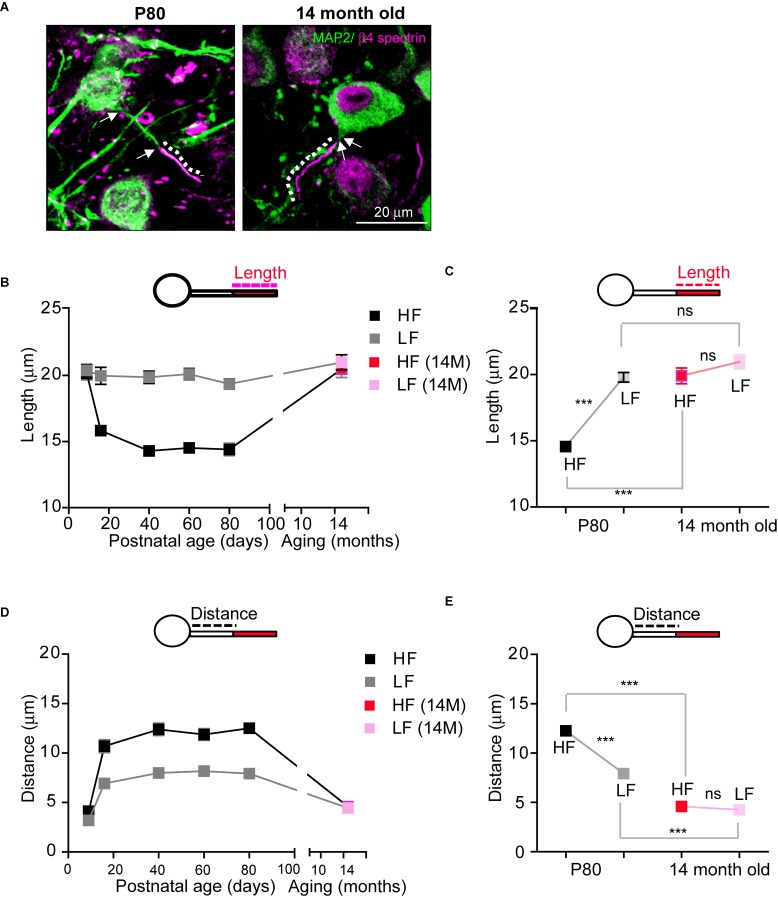
The structural stability of the AIS of MNTB neurons is disrupted in aged mice. (A) HF neurons were immunostained with MAP2 and β4 spectrin in adulthood (P80) and in an aged mouse (14-month-old; 14M). The dotted line and white arrow indicate AIS length and distance, respectively. (B) The plot of AIS length in HF (black) and LF (gray) neurons through lifetime from P9 to 14M and AIS length of HF (red) and LF (pink) in aged mice. (C) Tonotopy of AIS length in MNTB neurons from adult (at P80, black) and aged (14M, magenta) mice. ∗∗∗p < 0.0001, Mann–Whitney U test. (D) The plot of AIS location in HF (black) and LF (gray) neurons through lifetime from P9 to 14M and AIS location of HF (red) and LF (pink) in aged mice. (E) Tonotopy of AIS location from adult (at P80, black) and aged (14M, red) mice. ∗∗∗p < 0.0001, unpaired t-test.